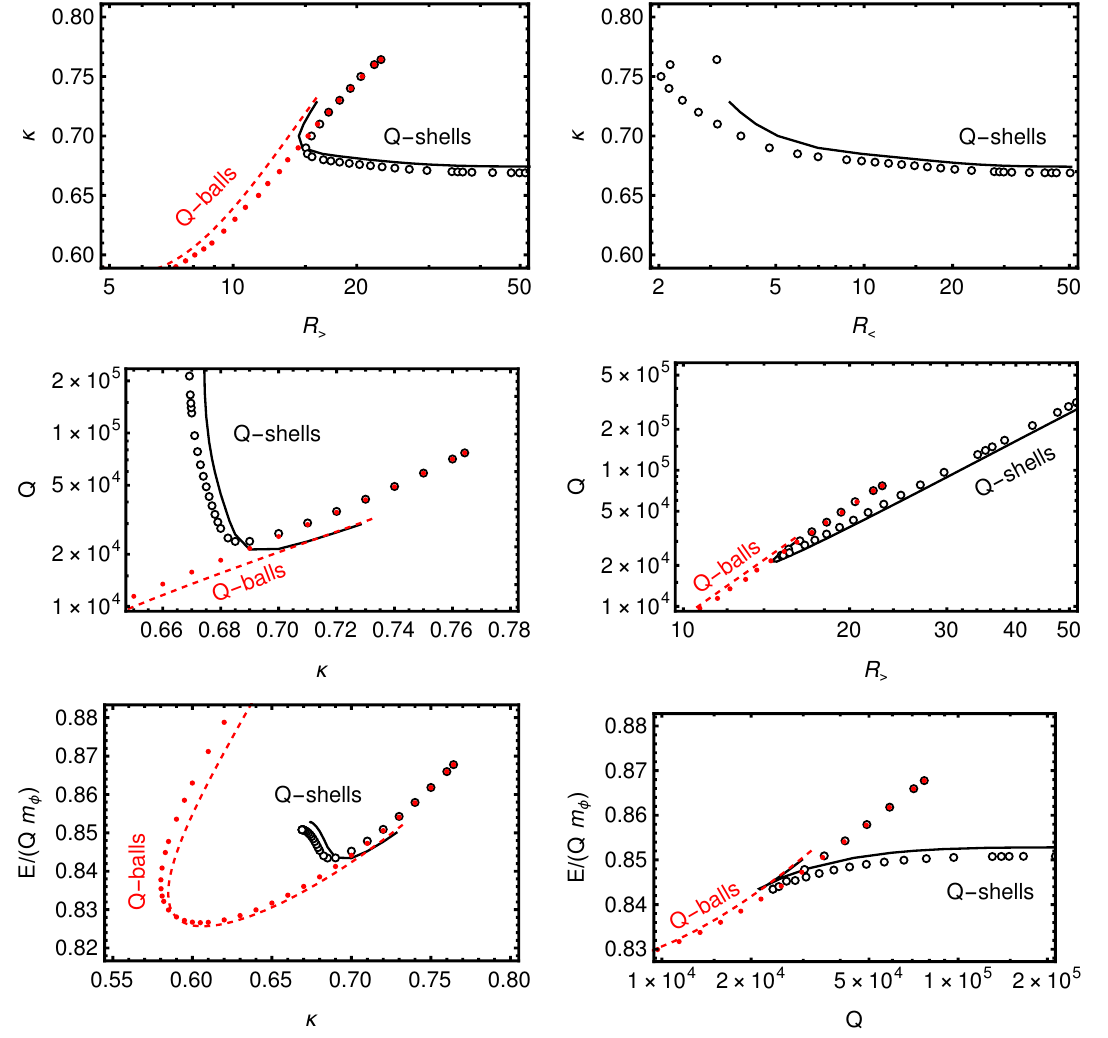
Figure 5 . Proca solitons for the benchmark point α = M = Ω 0 / 10 = 1 / 10 , φ 0 = m φ . The red points correspond to exact Q-ball solutions, the dashed red line to our prediction from eqs. (4.4) and (4.5); the full Q-ball branch is shown in figure 3. The black circles are exact Q-shell solutions and the black line our analytical approximation. Notice that the wide Q-shells are degenerate with Q-balls and cease to exist for κ > 0 . 76 due to the instability described in eq.